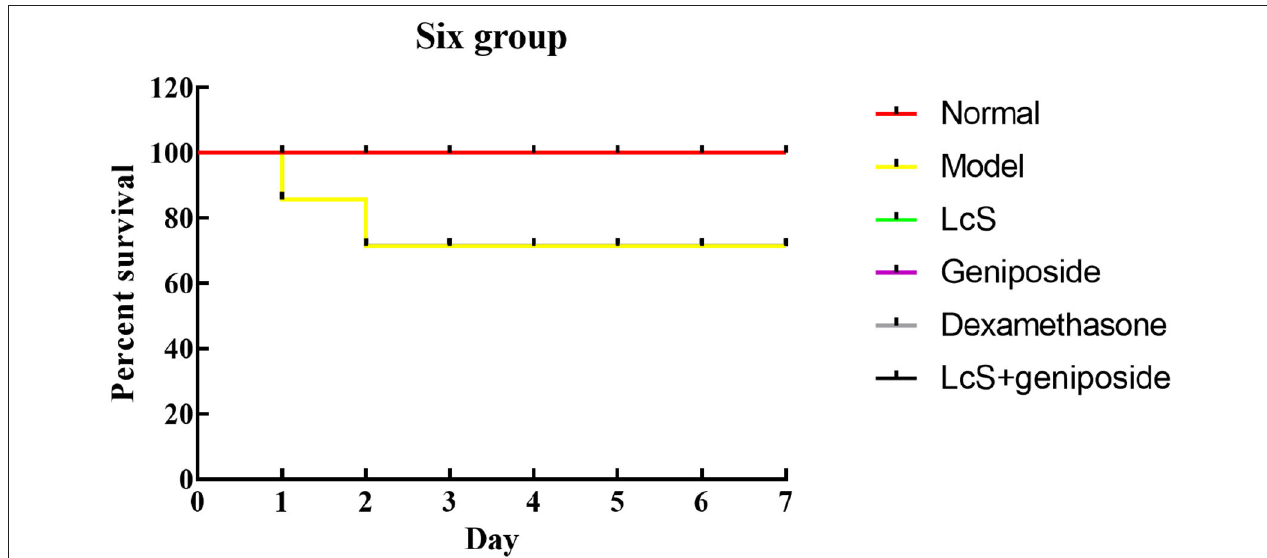
FIGURE 1 | Survival analysis of sepsis mice in Kaplan-Meier curve. Normal: untreated mice; model: mice with induced sepsis; Lactobacillus casei strain Shirota (LcS): 5 × 10 7 colony-forming unit (CFU)/kg-treated mice with sepsis; geniposide: 50 mg/kg geniposide-treated mice with sepsis; dexamethasone: 1 mg/kg dexamethasone-treated mice with sepsis; LcS + geniposide: 5 × 10 7 CFU/kg LcS and 50 mg/kg geniposide-treated mice with sepsis.